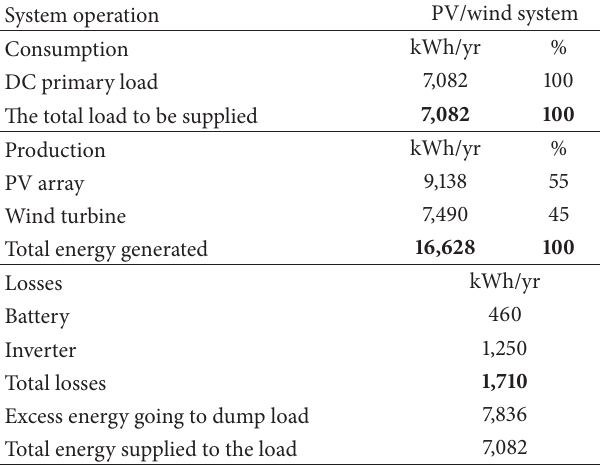
Table 3: Simulation results of the electricity production (kWh/yr), battery and inverter losses, and excess energy of the energy system configuration